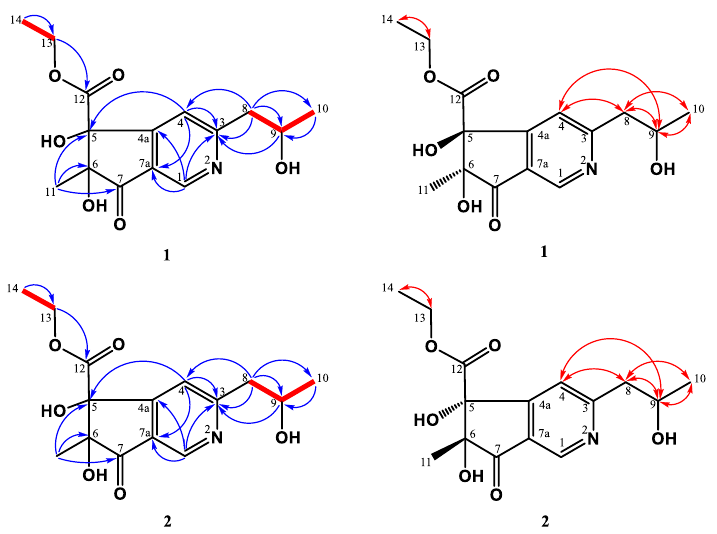
Figure 2. Key 1 H- 1 H COSY ( ━ ), HMBC (H → C), and NOESY (H ↔ H) correlations of 1 and 2 . All spectroscopic data of individual compounds 1 and 2 were explained by a dia- stereomeric character within stereochemical centers C-5/C-6. The ECD spectra of four possibilities were calculated at B3LYP/6-311G(d,p) level with IEFPCM in MeOH [72,73] (Figure 3). After comparison between the experimental spectra of compounds 1 and 2 and the computed electronic circular dichroism (ECD) spectra (Figure 3), compound 1 showed a positive Cotton effect at 200–203 nm and 240–260 nm and a negative Cotton effect at 225–235 nm, similar to those of (5 S ,6 S )-conformation, and compound 2 showed a positive Cotton effect at 200–220 nm, 220–235, and 310–360 nm and a negative Cotton effect at 240–270 nm, similar to those of (5 R ,6 R )-conformation. Thus, the absolute configurations of compounds 1 and 2 were assigned and named (5 S ,6 S )-monaspurpyridine A and (5 R ,6 R )-monaspurpyridine A, respectively.